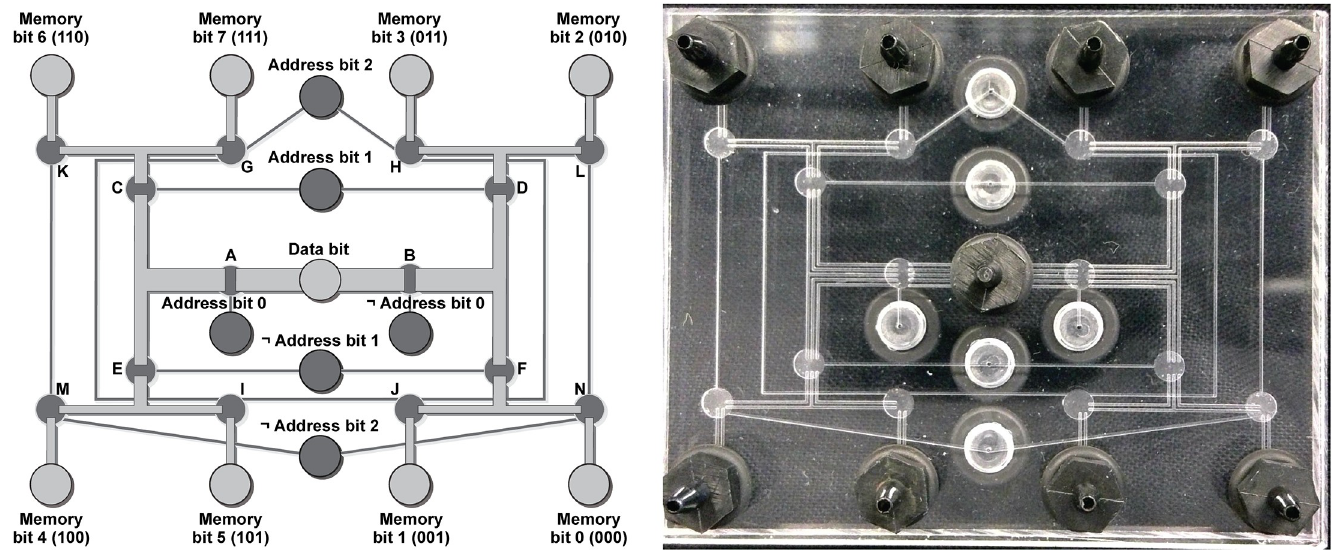
Fig 5. Design and photograph of a pneumatic eight-bit RAM for controlling soft robotic fingers. The 6.35 cm × 5.08 cm chip includes eight ports for connecting fingers to the Memory bits, a single Data bit connection that sets the state (contracted or extended) of each finger, three Address bit connections (and their negations, marked with “ ¬ ”) which are used to select which Memory bit (and therefore which finger) to set, and 14 pneumatic valves (labeled A through N) that execute the logical functions shown in the blue box in Fig 4.